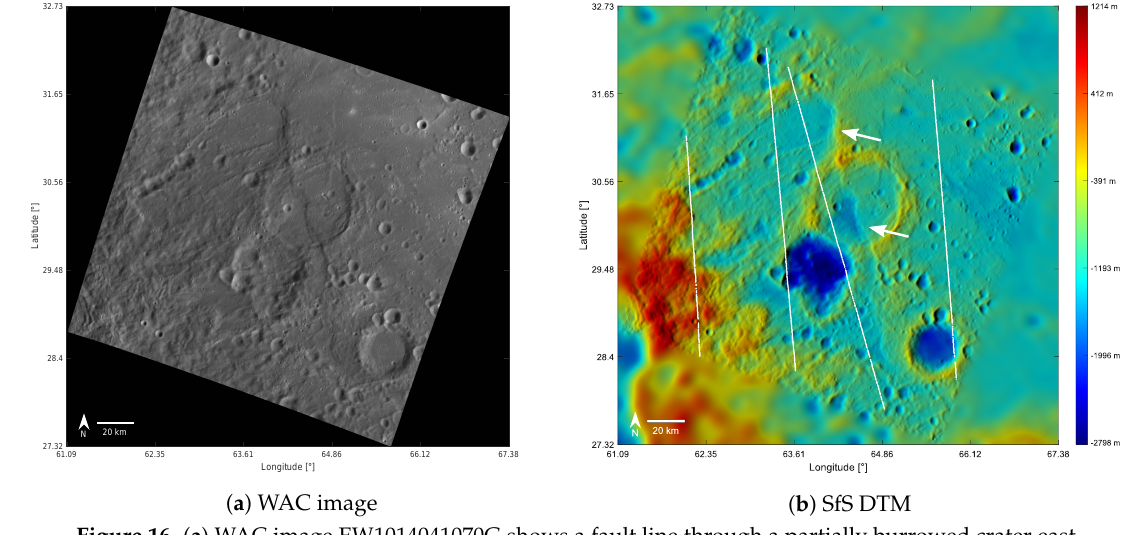
Figure 16. ( a ) WAC image EW1014041070G shows a fault line through a partially burrowed crater east of the Rachmaninoff basin. ( b ) Color-coded SfS DTM created from the image. The white lines indicate the position of the MLA profile, the arrows indicate the fault